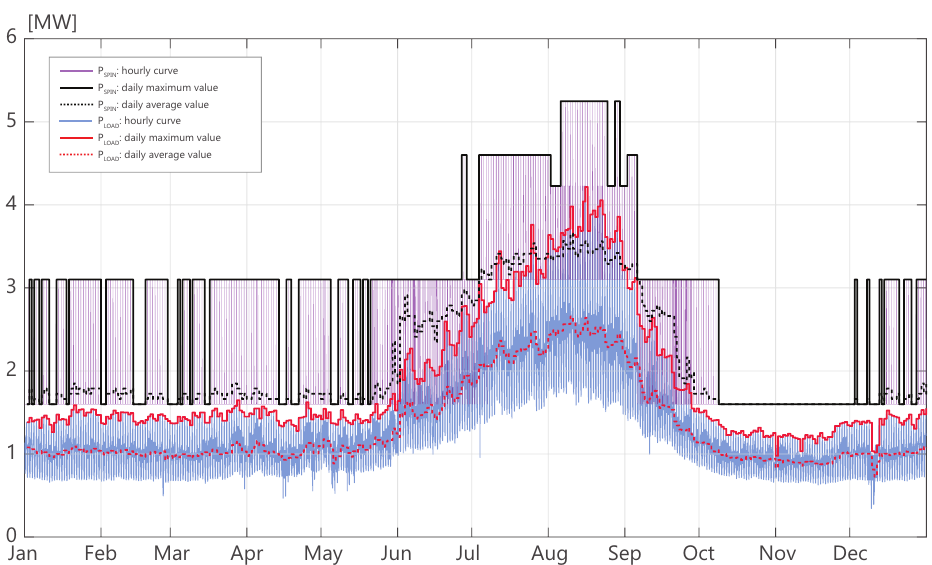
Figure 21. Hourly curve of spinning power P SPIN and load power P LOAD with the introduction of the BESS envisaged in the objective of 100% of the